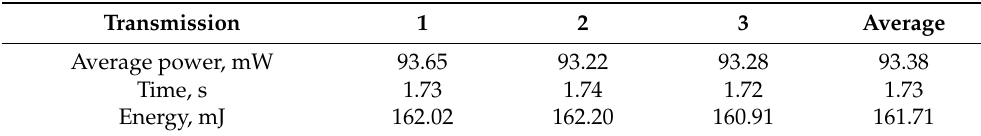
Table 2. Values of energy and power in the load.